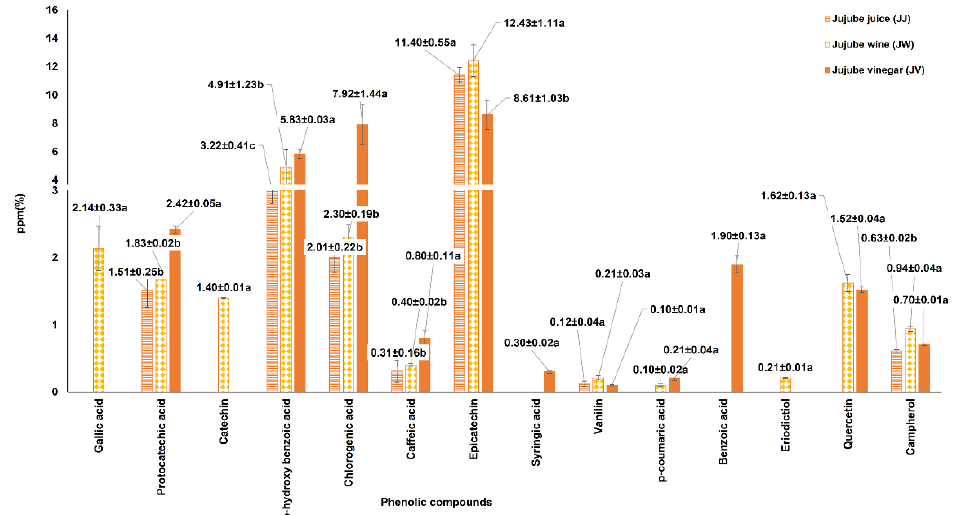
Figure 2. Phenolic compounds of jujube juice (JJ), jujube wine (JW), jujube vinegar (JV) (ppm). Different letters in the figure indicate significant differences between samples .